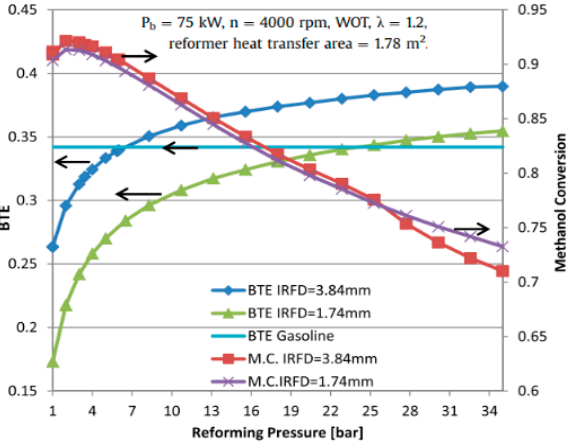
Figure 16. Relationship of methanol conversion and BTE on reforming pressure [286].